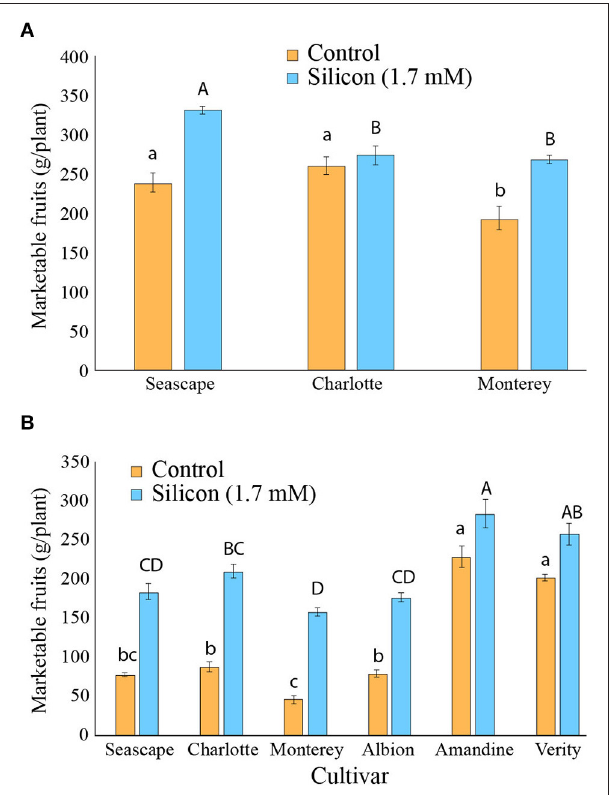
FIGURE 6 | Weight of marketable fruits for strawberry plants treated or not with potassium silicate in a high tunnel commercial setting. (A) Summer 2014. (B) Summer 2015. Each value represents the mean ± SE ( n = 4). Multiple comparison test (Tukey HSD) has been done on each treatment independently when the ANOVA was significant. Means with different letters are significantly